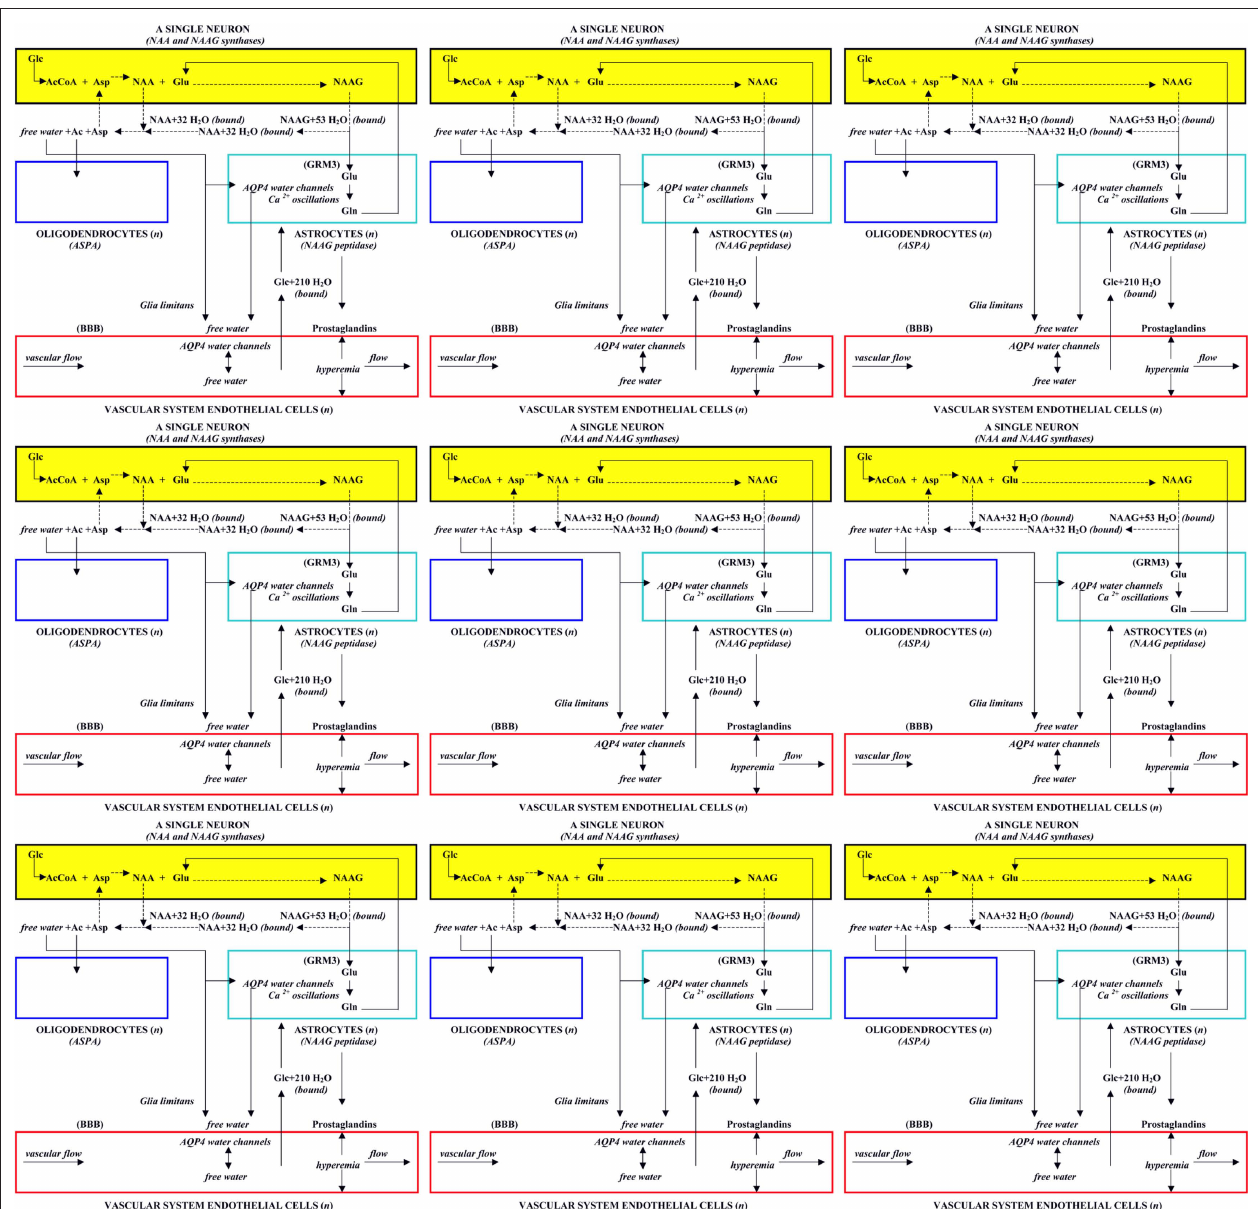
Figure 4 | Nine structural units, each containing a three-cell metabolic unit, a four-cell physiological operating system, and comprising many binary functional brain